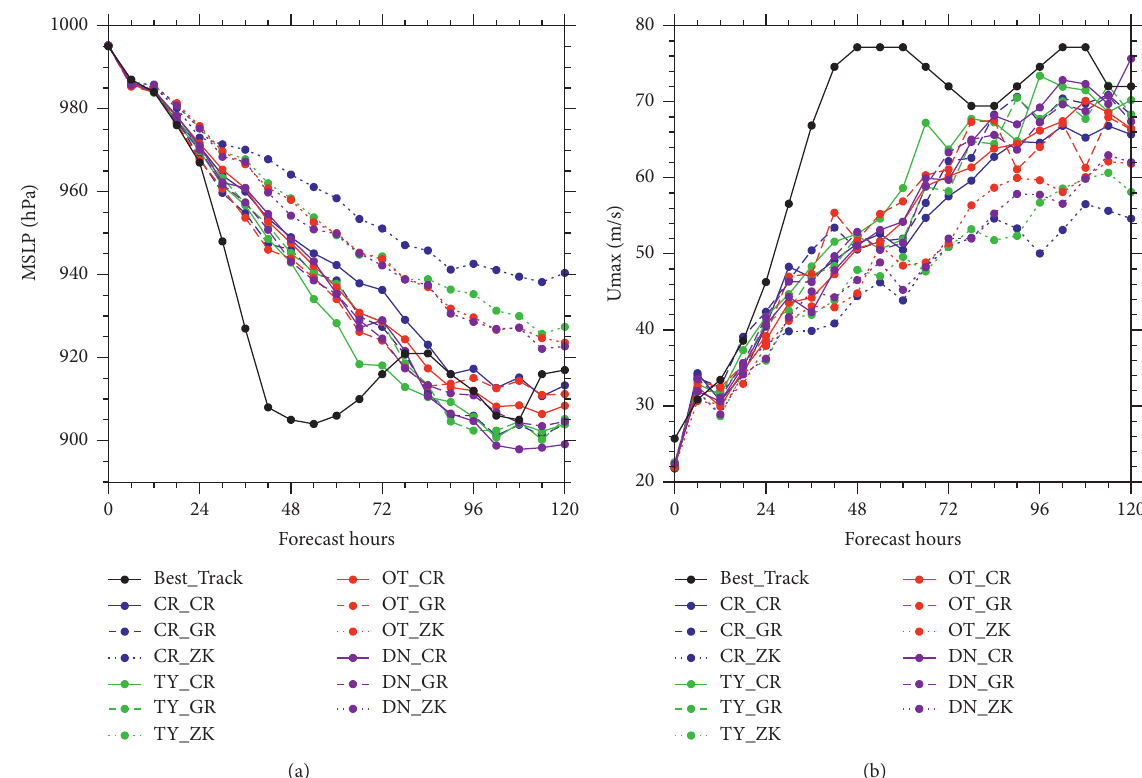
Figure 4: Comparison between Yutu’s JTWC Best-Track data and simulated intensities (a) for minimum sea level pressure and (b) for maximum wind speed at 10m level above the sea surface.